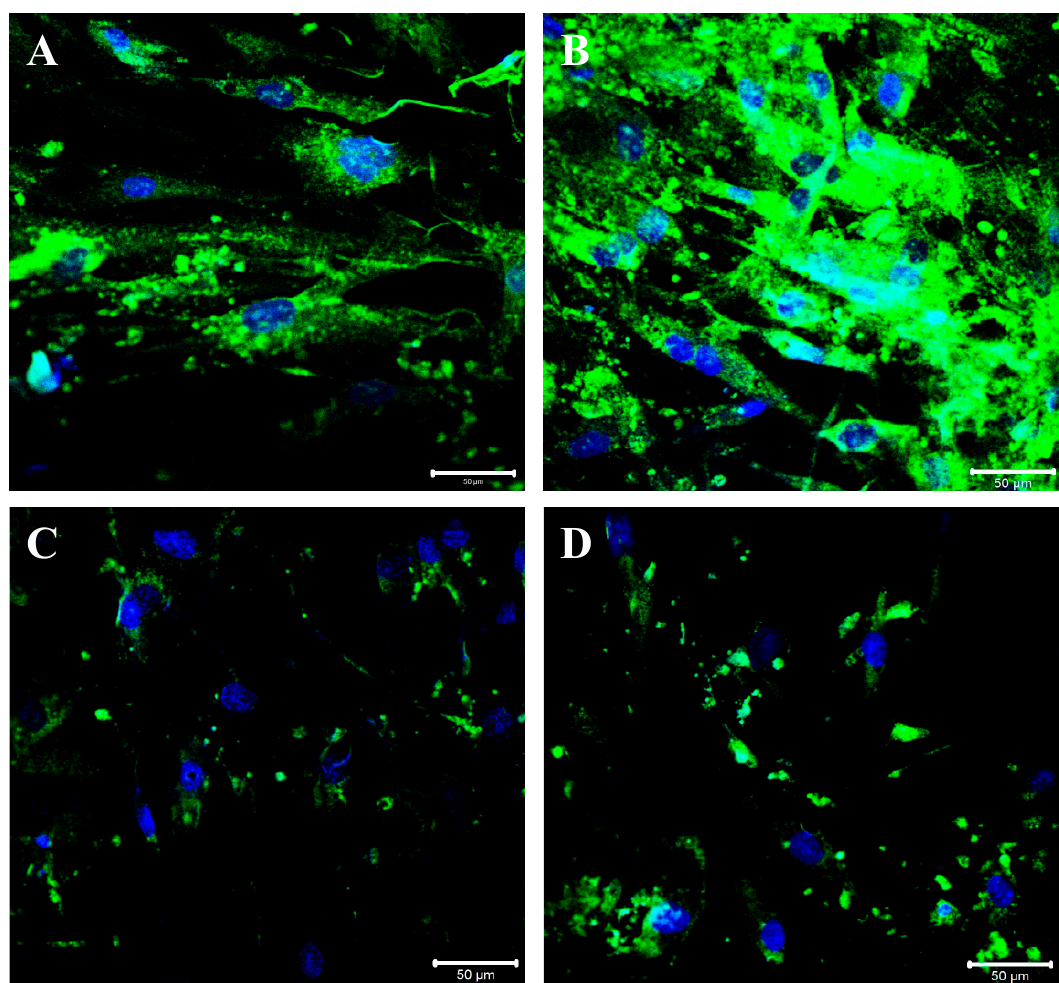
Figure 6. Compound panel of immunofluorescence reactions using an anti-biglycan antibody (green fluorescence). The control cells show an intense biglycan fluorescence pattern, mainly located at the perinuclear and cytoplasmic level ( A ); the cells treated with TGF- β are characterized by an increased biglycan fluorescence pattern that is distributed at the perinuclear and cytoplasmic level ( B ). The cells treated with TGF- β /Istradefylline ( C ) and TGF- β /ZM241385 ( D ) show a strong reduction in the biglycan staining pattern at the membrane and cytoplasmic level; the fluorescence pattern remains more detectable in the perinuclear region.